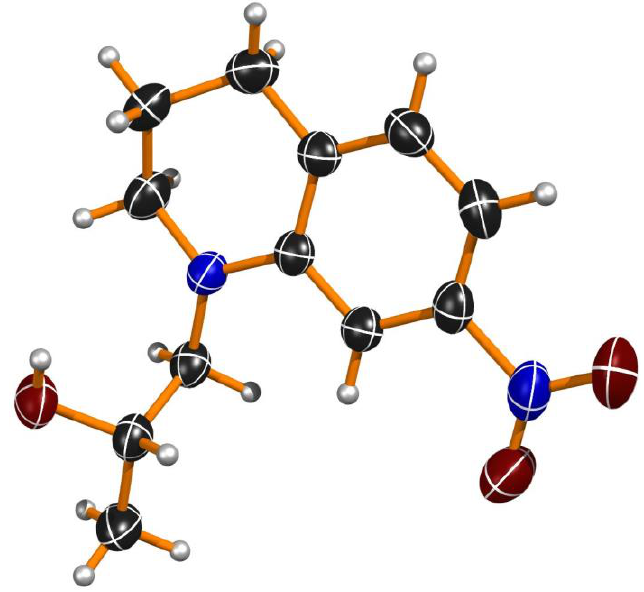
Figure 2. Crystal structure of (2 S )-1-(7-nitro-3,4-dihydroquinolin-1(2 H )-yl)propan-2-ol [( S )-(+)- 2c ]. The following crystal structure has been deposited at the Cambridge Crystallographic Data Centre and allocated the deposition number CCDC-2217269. Ellipsoids are set to 50% probability. Nitrogen atoms are presented in blue, oxygen atoms in maroon, carbon atoms in black, whereas hydrogen atoms in gray.